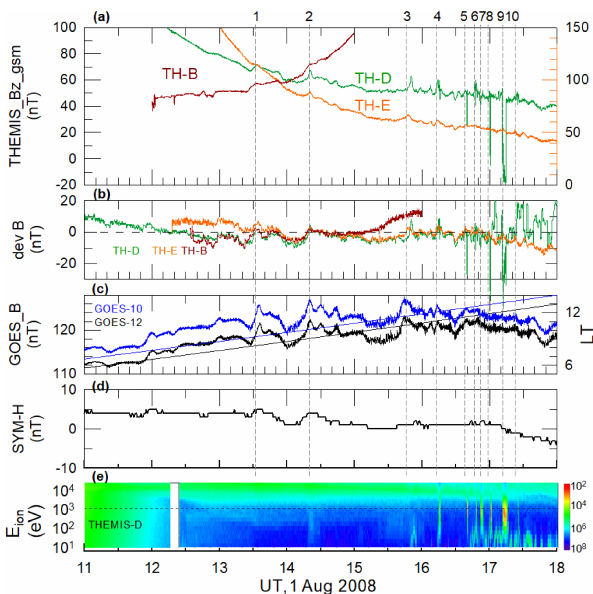
Figure 6. Satellite measurements of magnetic fields and plasma in the dayside magnetosphere and geomagnetic activity. (a) The B z GSM components from THEMIS probes TH-B (brown), TH-E (or- ange), and TH-D (green). The left y axis corresponds to the mag- netic measurements from TH-B and TH-D, and the right y axis to TH-E. (b) The detrended magnetic fields for THEMIS. (c) The GOES-12 (black) and GOES-10 (blue) measurements of magnetic field strength (left y axis) and local time (right y axis). (d) The SYM-H index; and (e) the ion spectrogram from TH-D (ion flux is in units of eVcm − 2 ssreV). Dashed lines, numbered from 1 to 10, indicate magnetic and plasma disturbances observed by